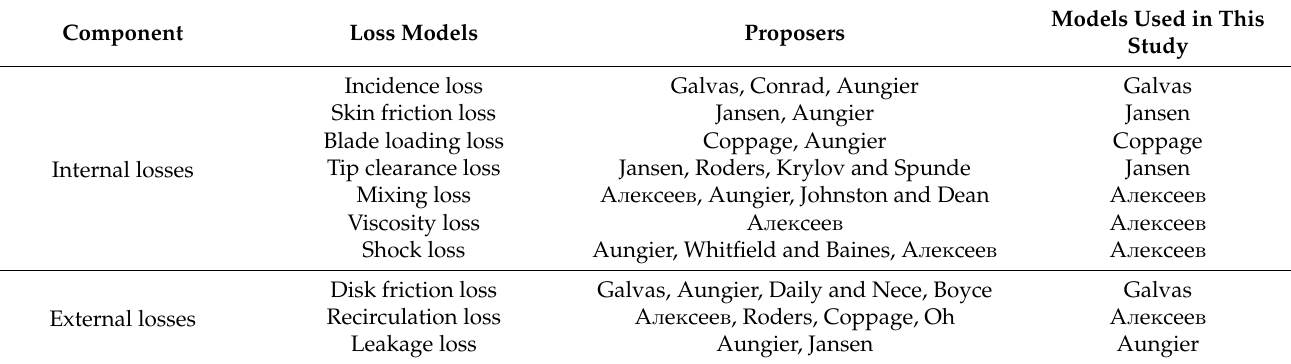
Table 2. Loss models and models used in the study.